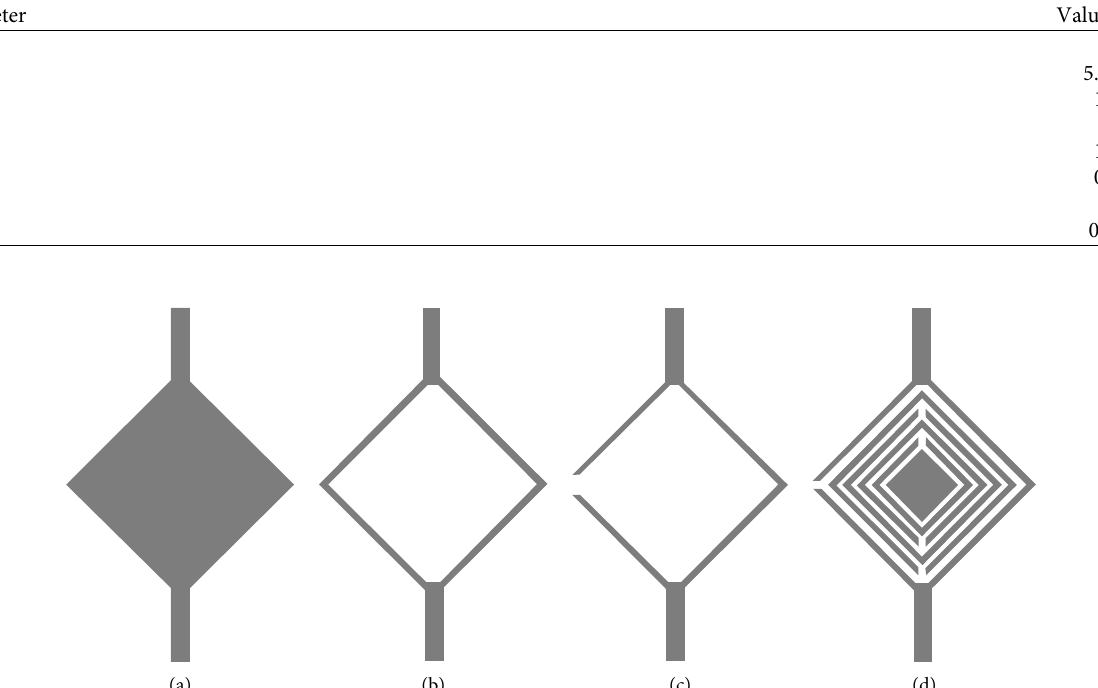
Figure 1: Proposed filter design configuration: (a) top view, (b) bottom view. Table 1: Optimized design parameters of the proposed filter.